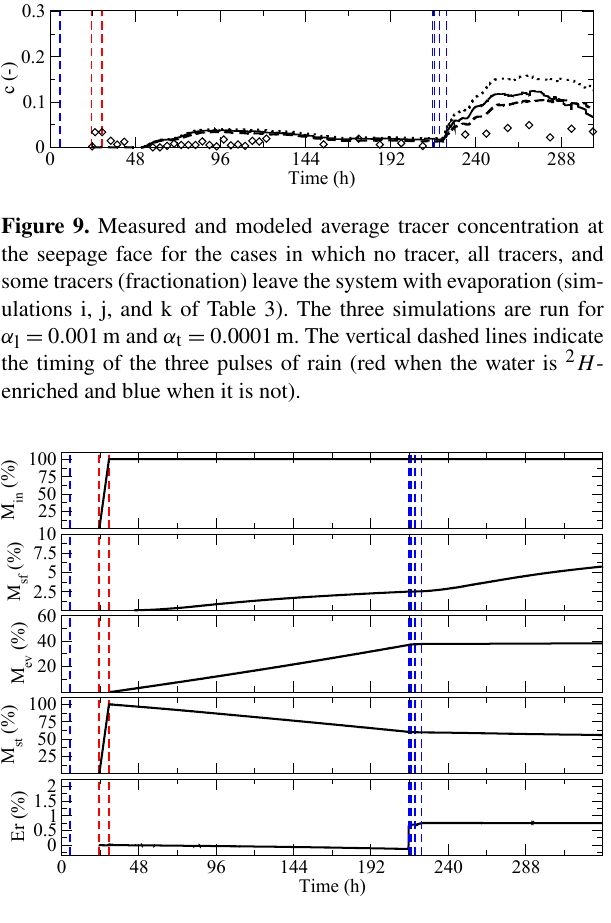
Figure 10. Simulated mass balance results for α l = 0 . 001m when the correction source term f c is added to the transport equation to perform isotopic fractionation (simulation k of Table 3). From top to bottom: 2 H mass that enters the system, M in (normalized with respect to the total mass added to the system during the simulation); that exits through the seepage face, M sf ; that exits through evapora- tion, M ev ; and that remains in storage, M st . The bottom graph shows the cumulative mass balance error E r = (M in − M sf − M ev − M st ) . The vertical dashed lines indicate the timing of the three pulses of rain (red when the water is 2 H -enriched and blue when it is not).